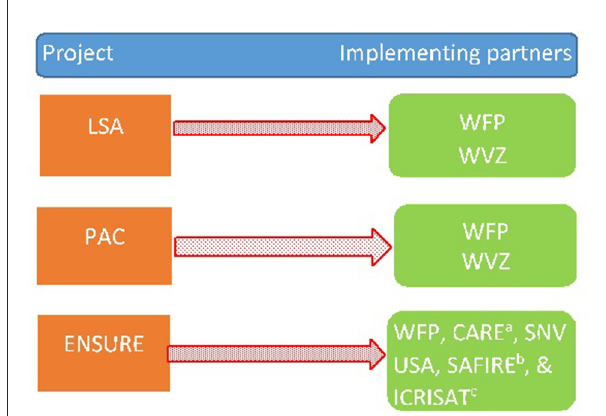
FIGURE2 Schematic presentation of the interventions and partnership of WVZ and other projects. a Cooperative for assistance and relief everywhere, Inc. implements ENSURE on behalf of CARE. b SAFIRE, Southern Alliance for Indigenous Resources. c ICRISAT, International Crops Research Institute for the Semi-Arid